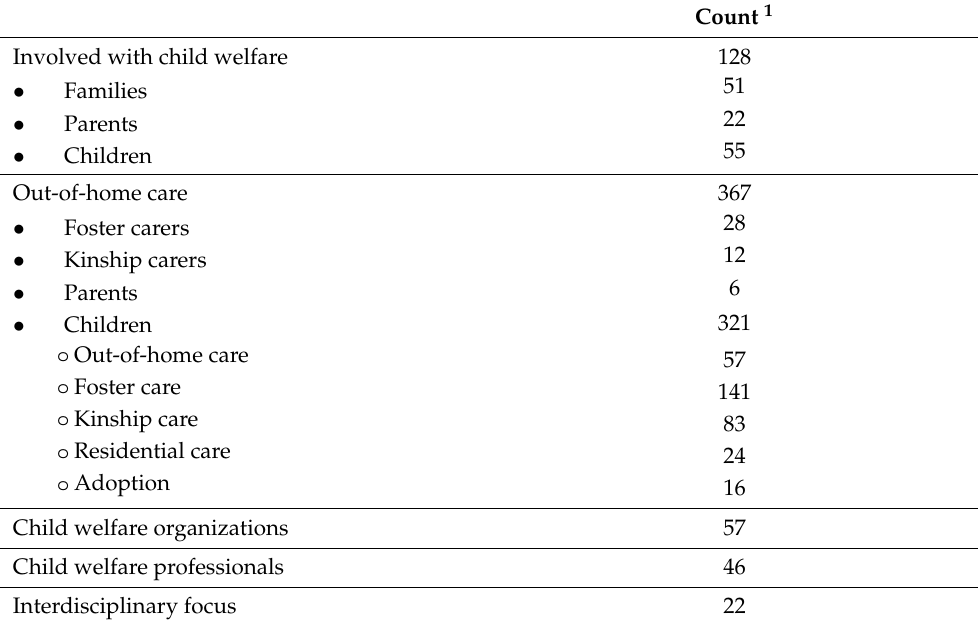
Table 4. Population Focus of Included Articles.